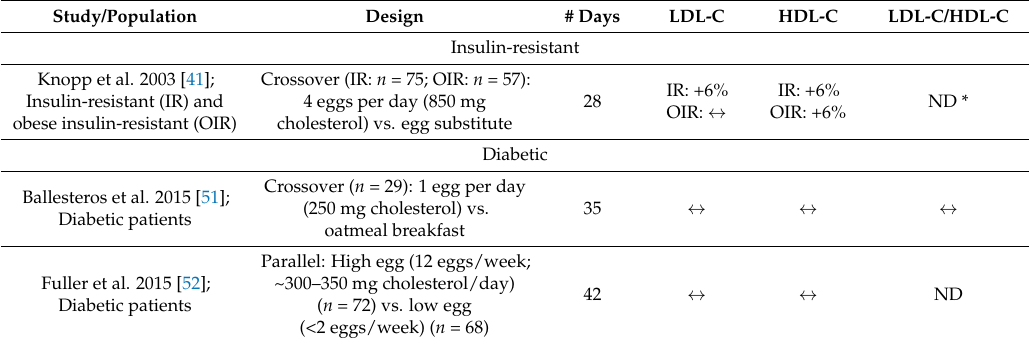
Table 2. Effects of additional dietary cholesterol from egg intake on serum lipids during weight maintenance: insulin-resistant and diabetic populations.